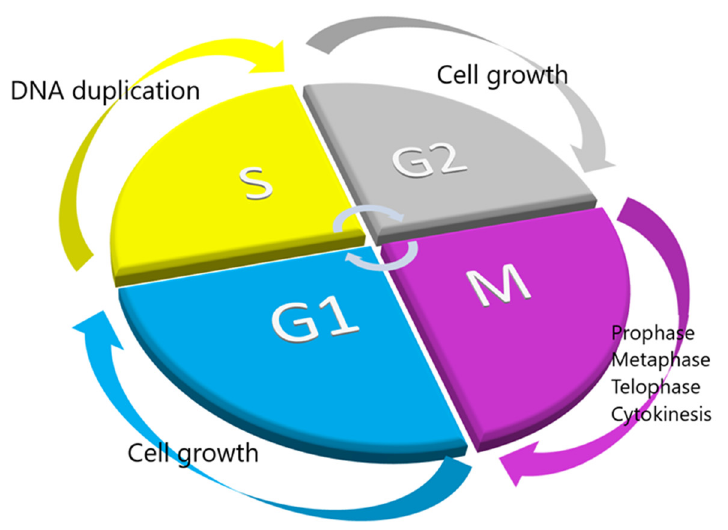
Figure 1. Stages of the cell cycle. The different phases of the cell cycle are presented in a circular fashion to indicate that the end of one cell’s division is the beginning of a new one.